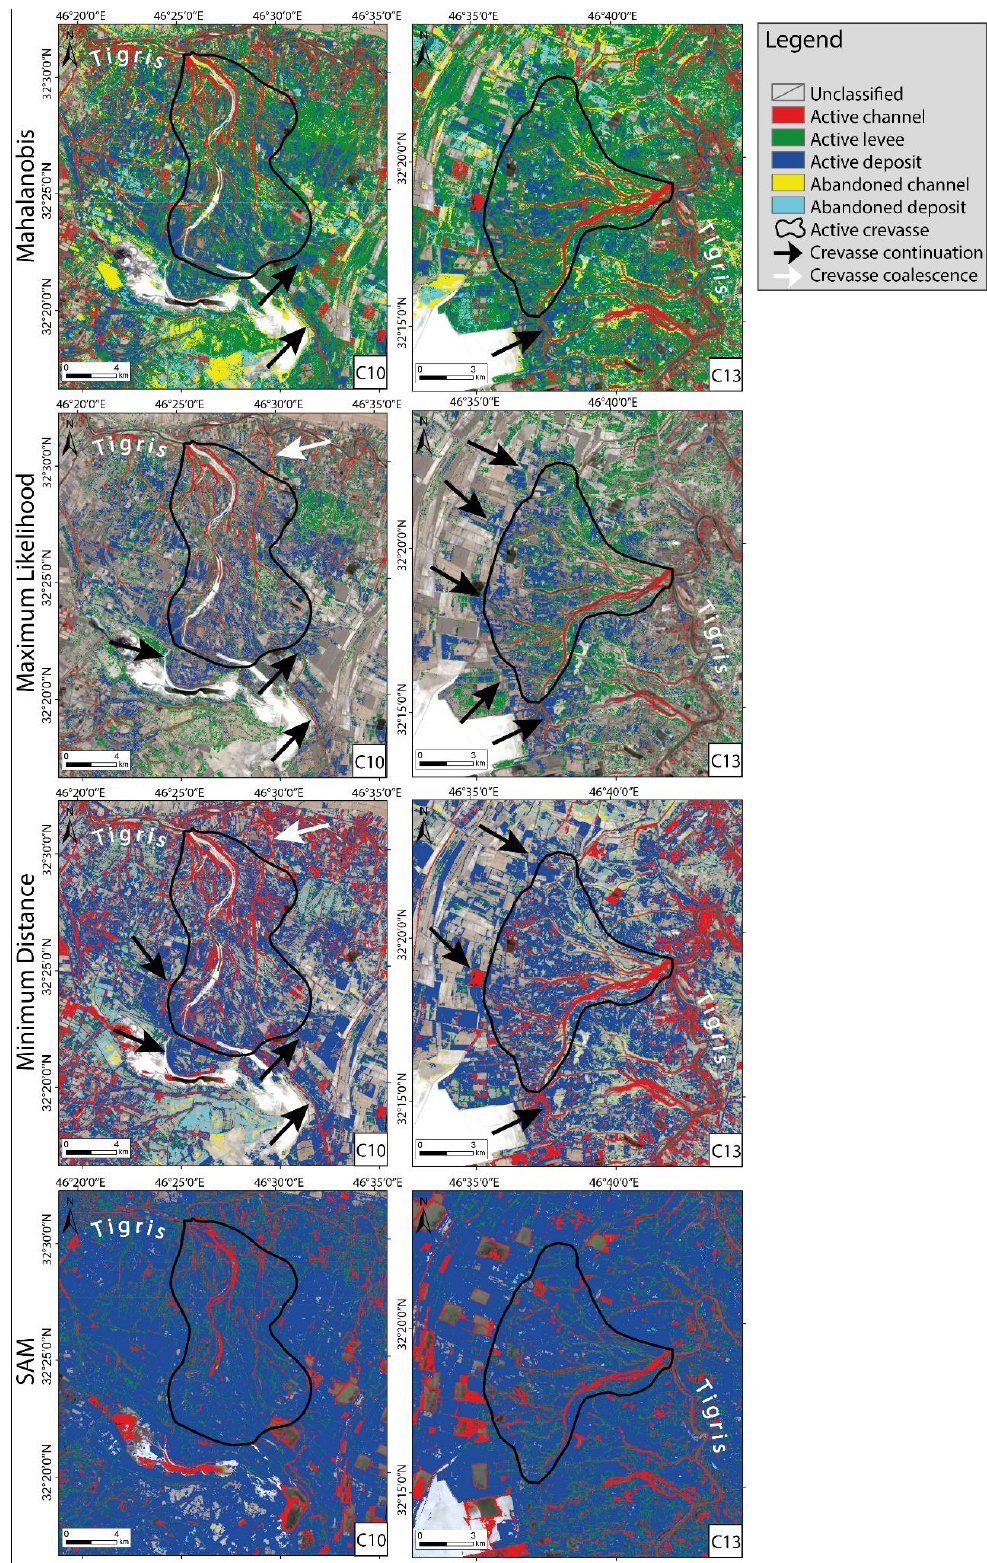
Figure 12. Classified active crevasse splay ( C10 , C13 ) using four classification methods. For the Mahalanobis and Minimum Distance the wettest period is shown, while for the Maximum Likelihood and SAM is the driest period.